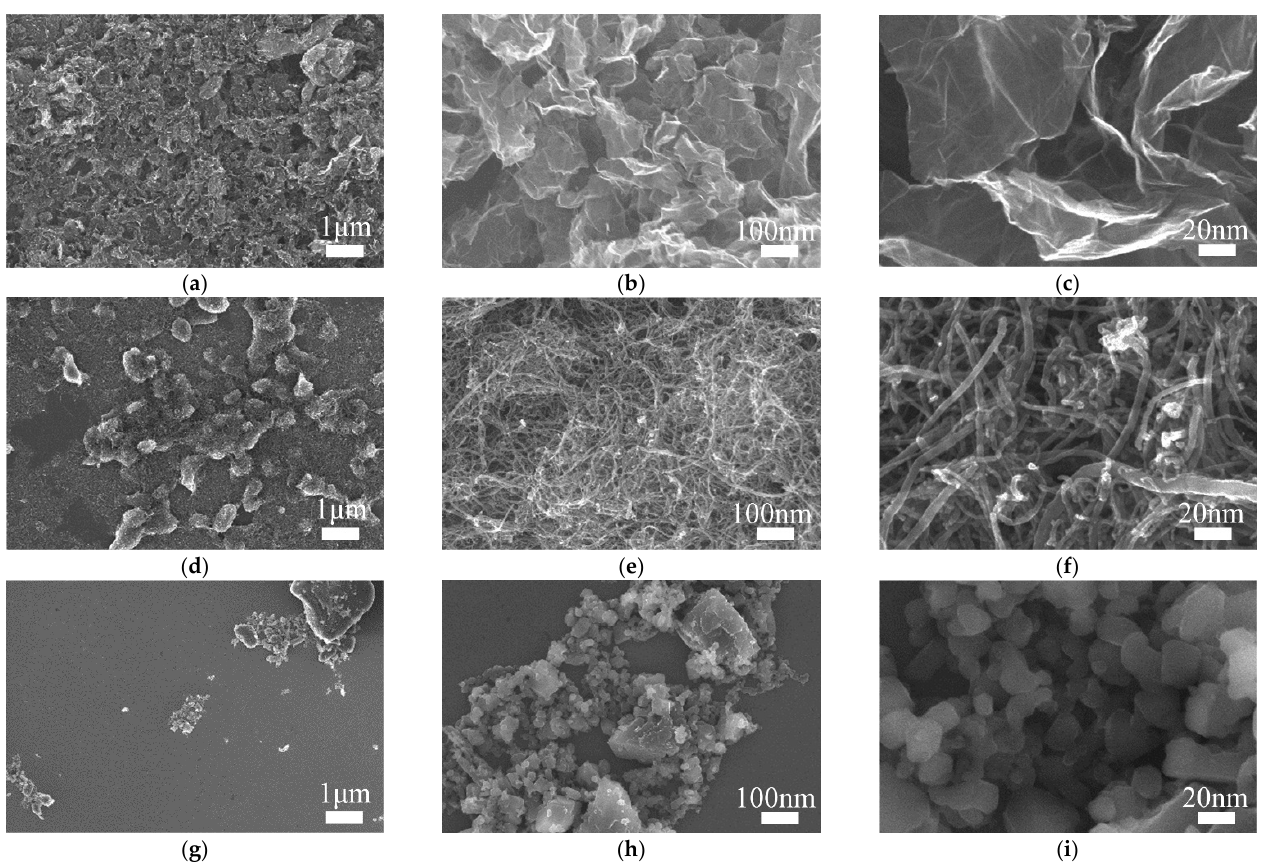
Figure 2. SEM images of the carbon ‐ based nanomaterials at different magnifications. ( a ) Graphene (GR) × 1 K. ( b ) GR × 10 K. ( c ) GR × 50 K. ( d ) Multi ‐ walled carbon nanotube (MWCNT) × 1 K. ( e ) MWCNT × 10 K. ( f ) MWCNT × 50 K. ( g ) C 60 × 1 K. ( h ) C 60 × 10 K. ( i ) C 60 × 50 K.